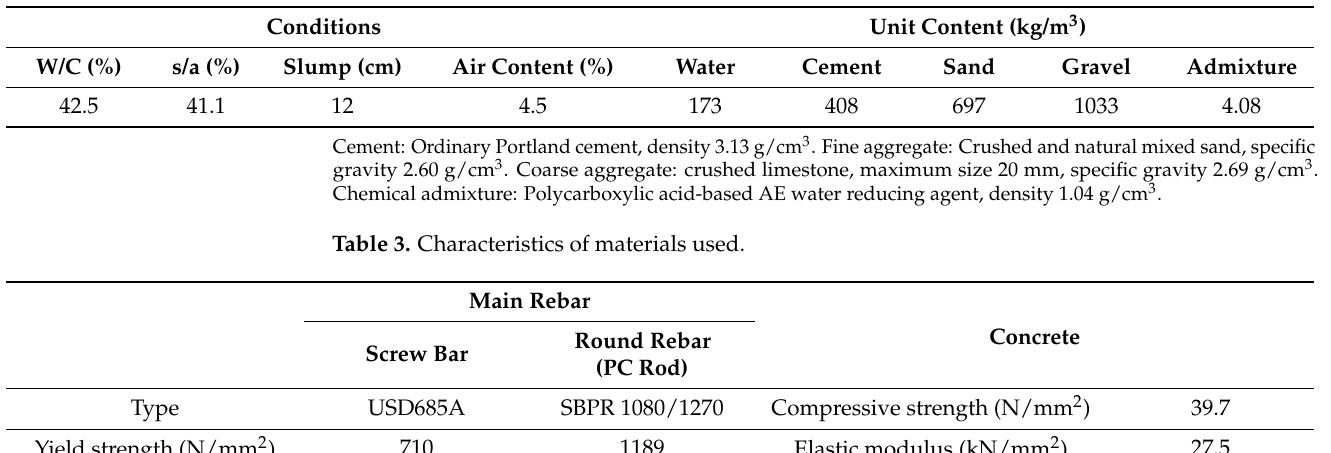
Table 2. Mix proportions of concrete.